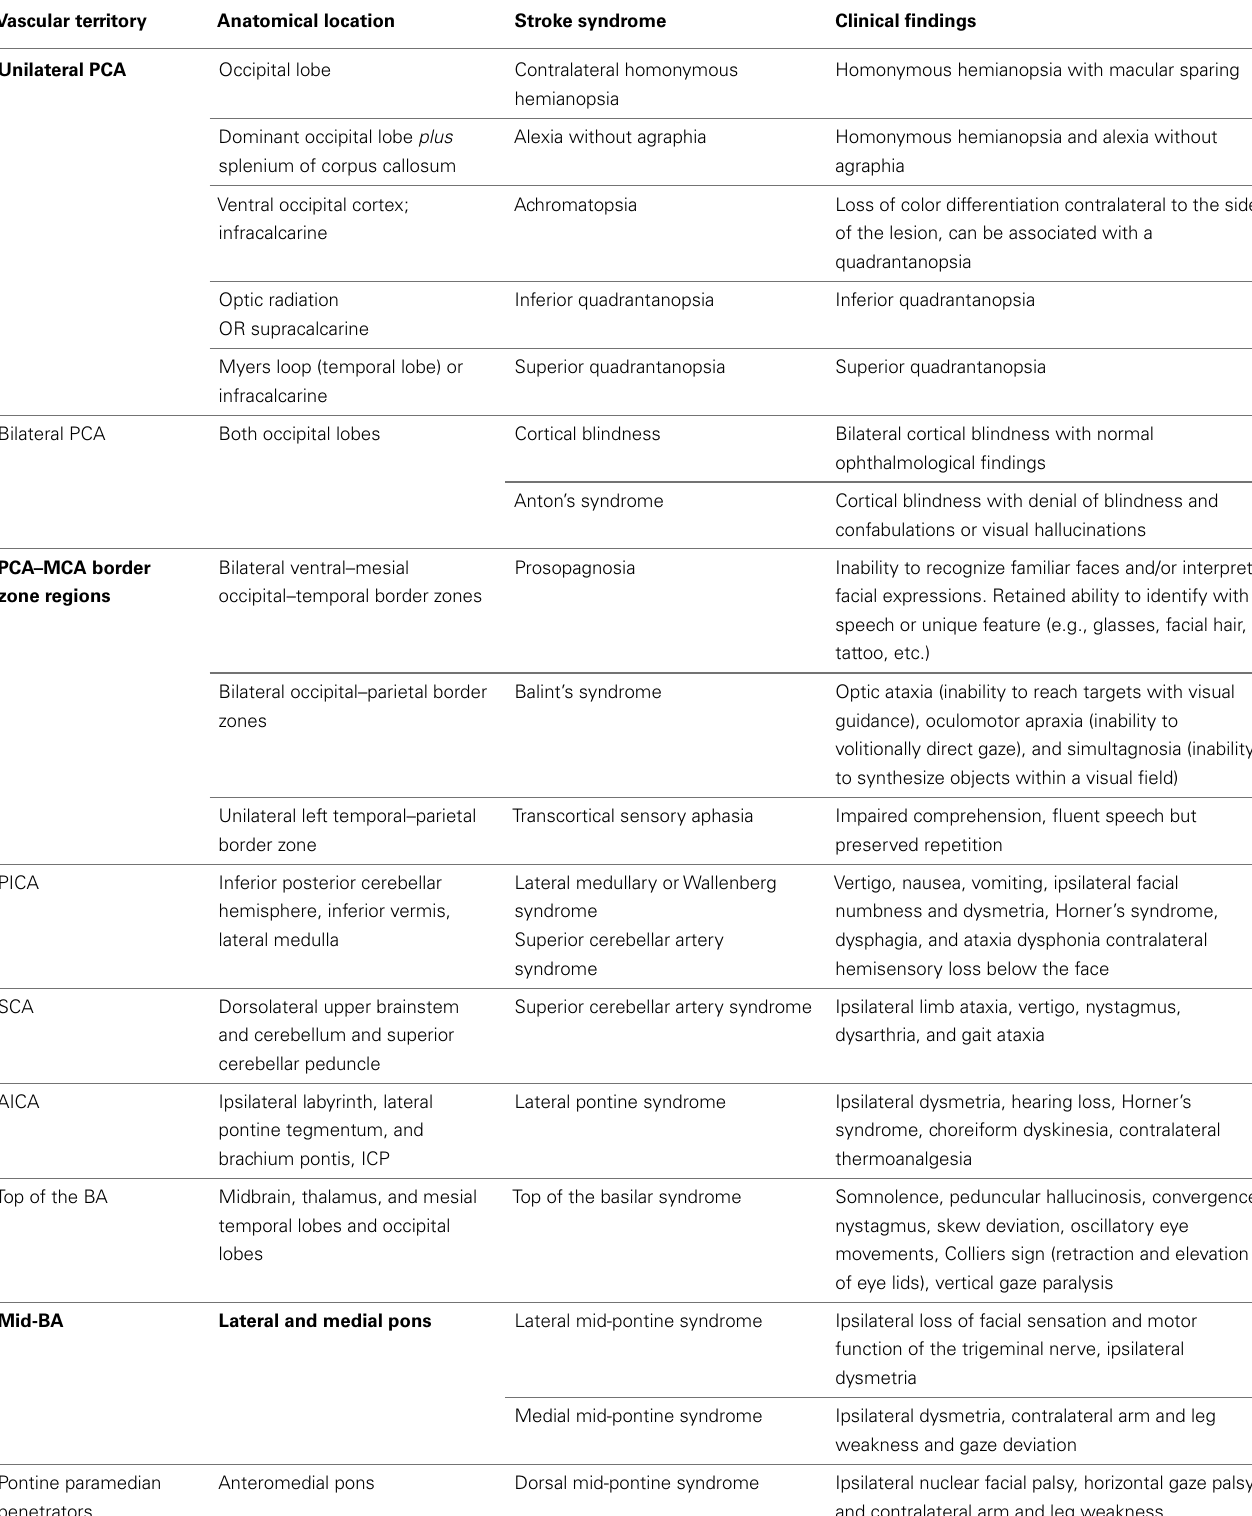
Table 1 |Vascular territories of the PC with corresponding clinical findings. Vascular